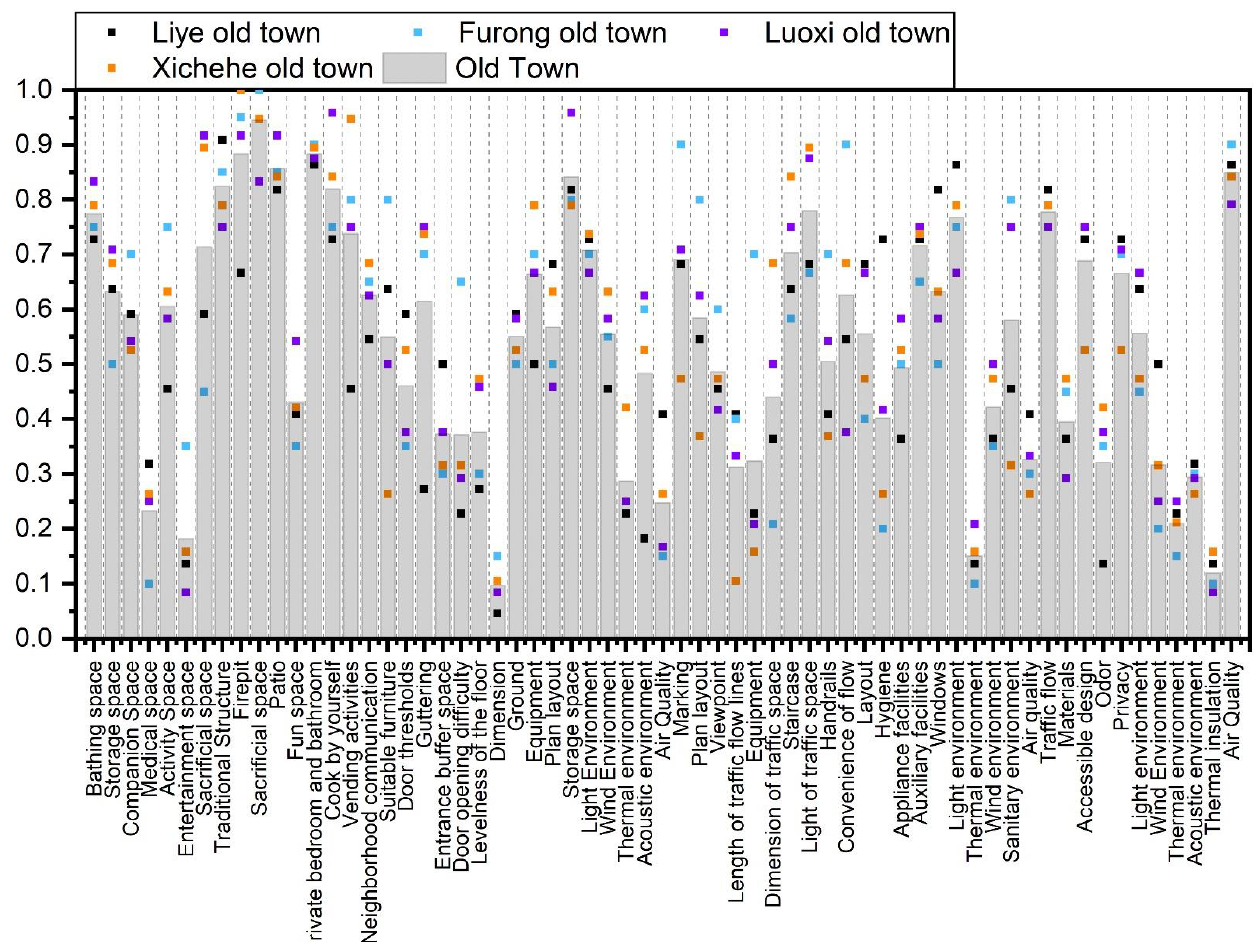
Figure 10. Questionnaire survey on the residential environment of the